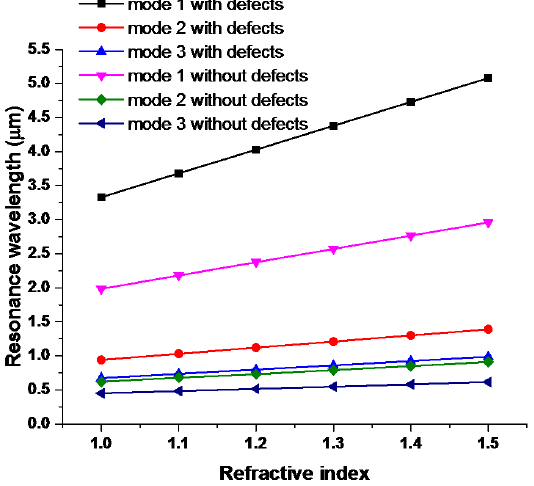
Figure 3. Resonant wavelengths versus the refractive index (RI) with and without silver nanorod defects in T-shape cavity. defects in T-shape